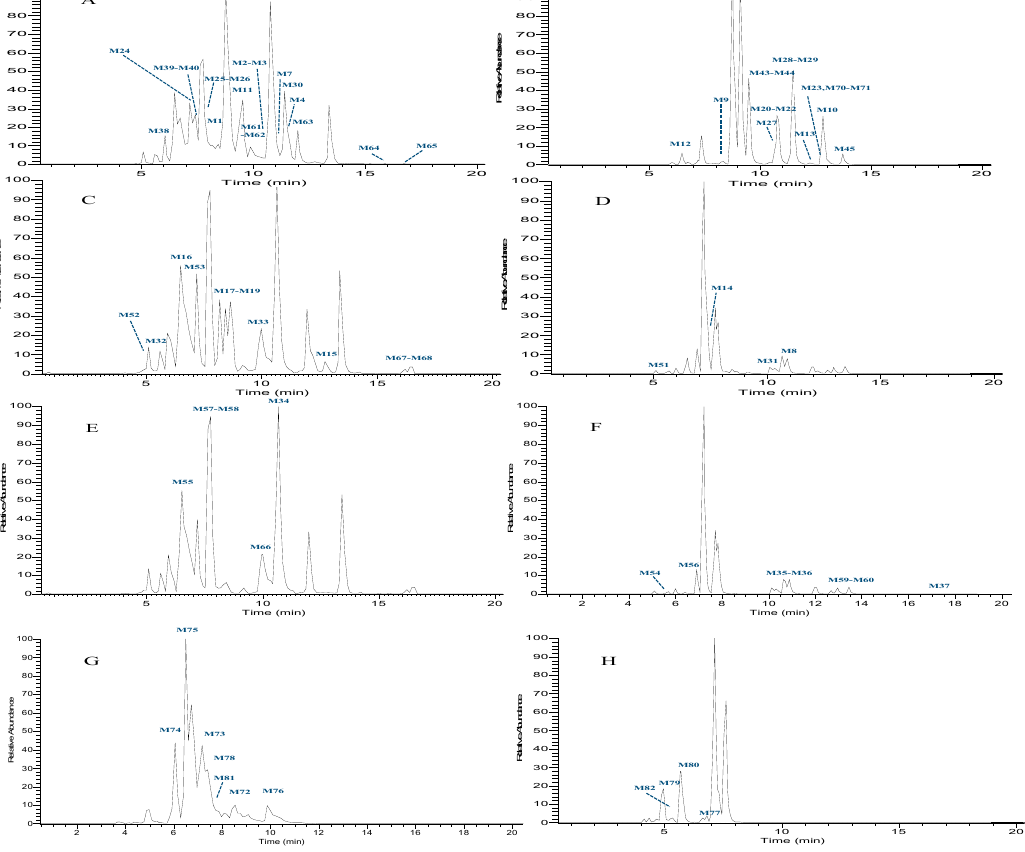
Figure 4. High resolution extracted ion chromatograms for HTF metabolites in rat urine in both negative and positive ion modes. ( A , B ) HREIC chromatograms of polymethoxyflavones in negative and positive ion modes; ( C , D ) HREIC chromatograms of polymethoxyflavanones in negative and positive ion modes; ( E , F ) HREIC chromatograms of polymethoxychalcone in negative and positive ion modes; ( G , H ) HREIC chromatograms of conjugate-metabolites in negative and positive ion modes.